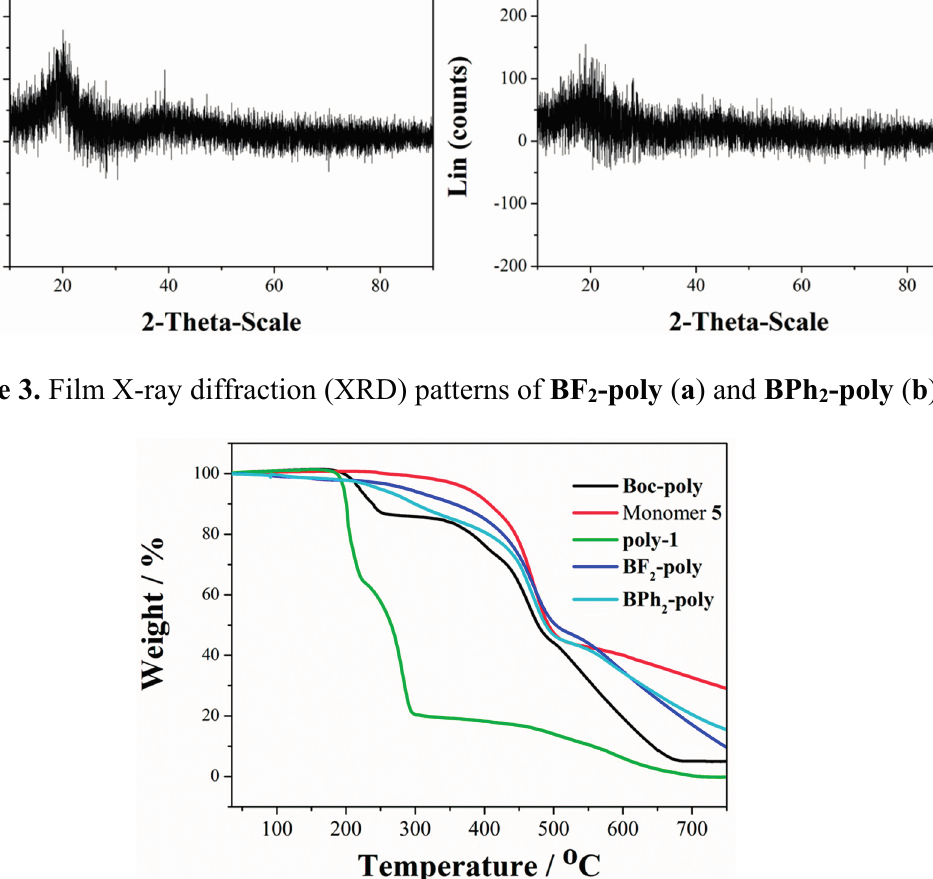
Figure 4. Thermogravimetric analysis (TGA) curves at a heating rate of 10 °C/min − 1